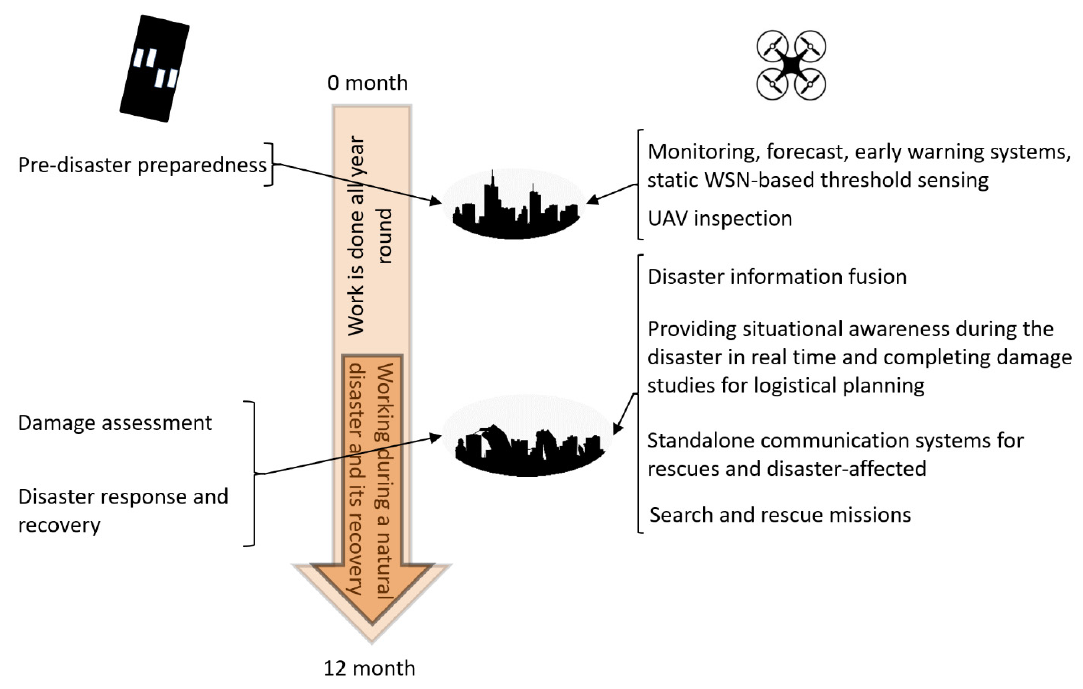
Figure 7. IUAVT in the disaster process control. Source: Generated by the